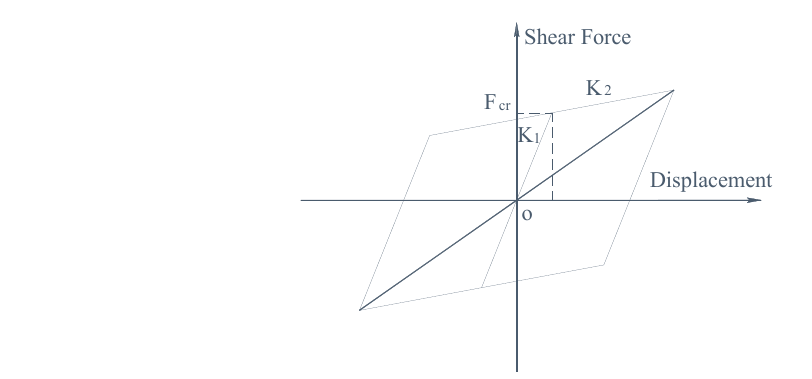
Figure 2: Bilinear element model of the support.